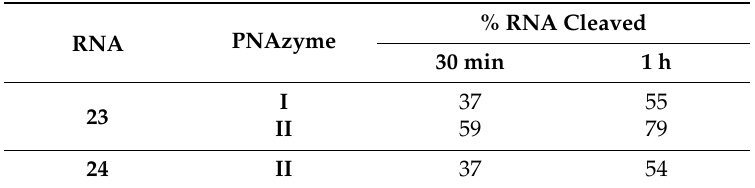
Table 4. The extent of cleavage of RNAs 23 and 24 after incubation in the presence of PNAzyme I or II over a period of 30 min and 1 h. 4